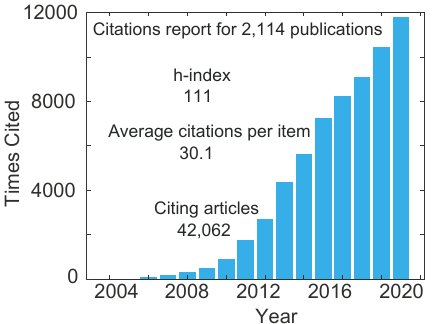
Figure 1: Emerging field of active plasmonics: The total number of citations to active plasmonics literature from 2004 to 2019 illustrates the remarkable growth in this field. (reference: Thomson Reuters Web of